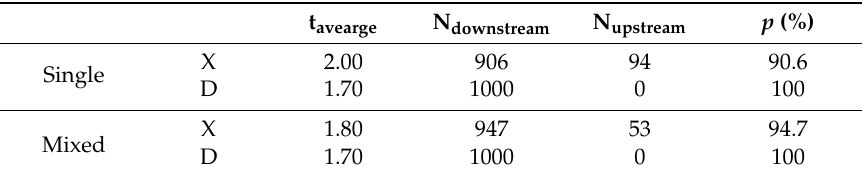
Table 9. Separation of 60 and 120 µ m